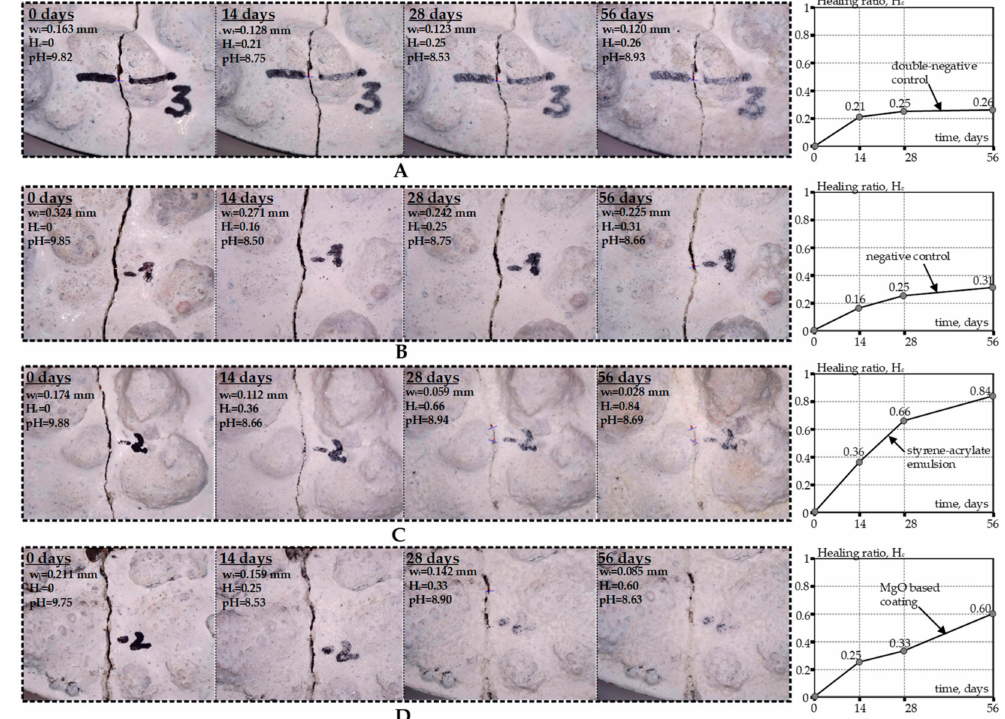
Figure 7. Optical measurement of crack healing in concrete specimens with coated expanded clay particles: ( A ) double-negative control with no coating and bacteria; ( B ) negative control specimen with embedded bacteria but no coating; ( C ) one layer of styrene–acrylate emulsion; ( D ) MgO-based coating. Here w i is the initial crack width; w t is the crack width after healing; H c is the healing ratio, calculated H c = (w i − w t )/w i